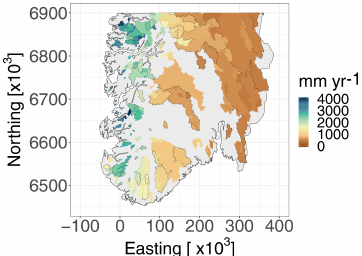
Figure 5. Mean annual runoff for 1981–2010 for 260 catchments in southern Norway, where only 83 of them are fully gauged (i.e. have annual data for each year in the study period). The 83 fully gauged catchments have black borders in the above plot. In addition, there are data available from 177 so-called partially gauged catchments. These have at least one annual observation between 1981 and 2010 and are visible as catchments without borders in the above figure. Among the 83 fully gauged catchments, 44 catchments are nested (53%), while 39 catchments do not overlap with any other catch- ment in the dataset. Data from the catchments in this figure are used to evaluate the framework’s ability to estimate mean annual runoff